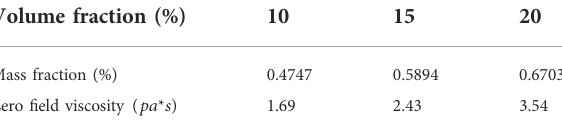
TABLE 3 Mass fraction and zero fi eld viscosity values of MRF with different volume